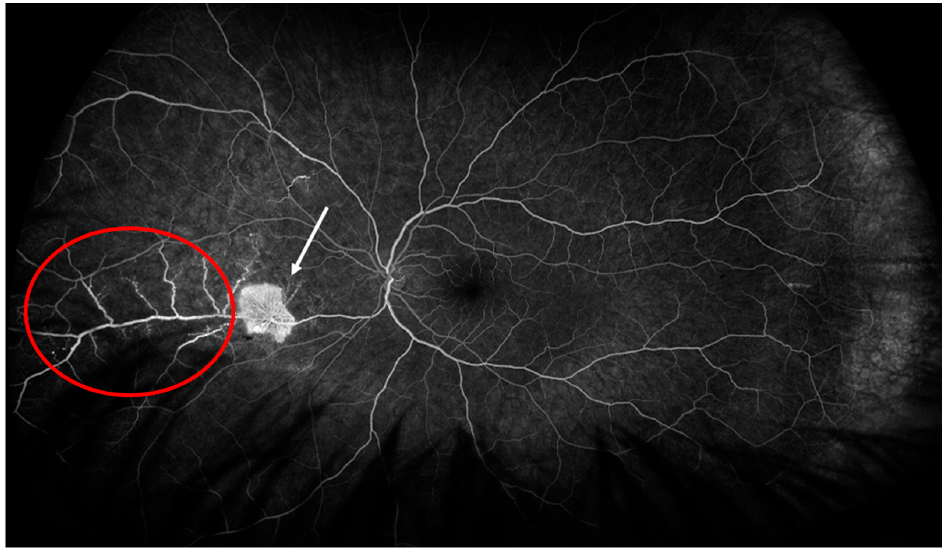
Figure 3. Fluorescein angiography of the left eye showing area of active vasculitis (red circle) and neovascularization (white